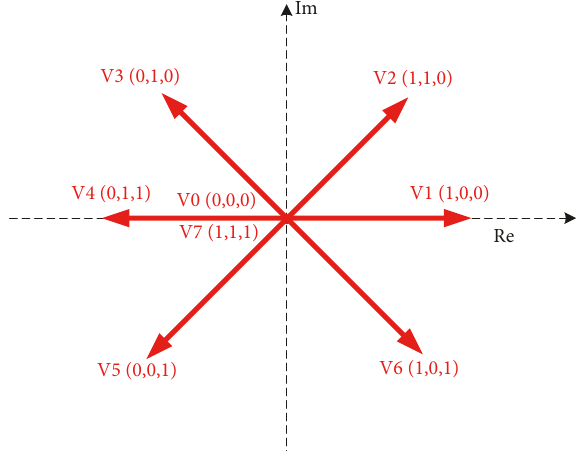
Figure 2: Possible voltage vectors generated by the